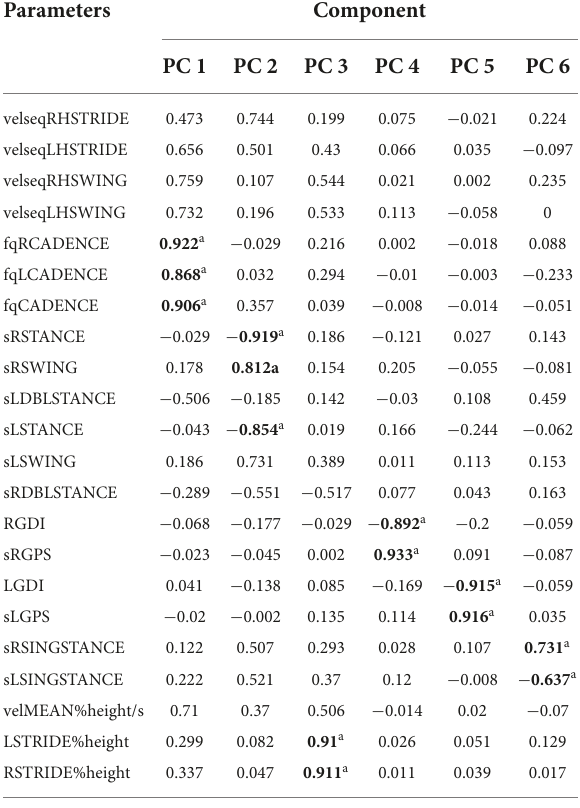
TABLE 2 Results of principal component analysis of